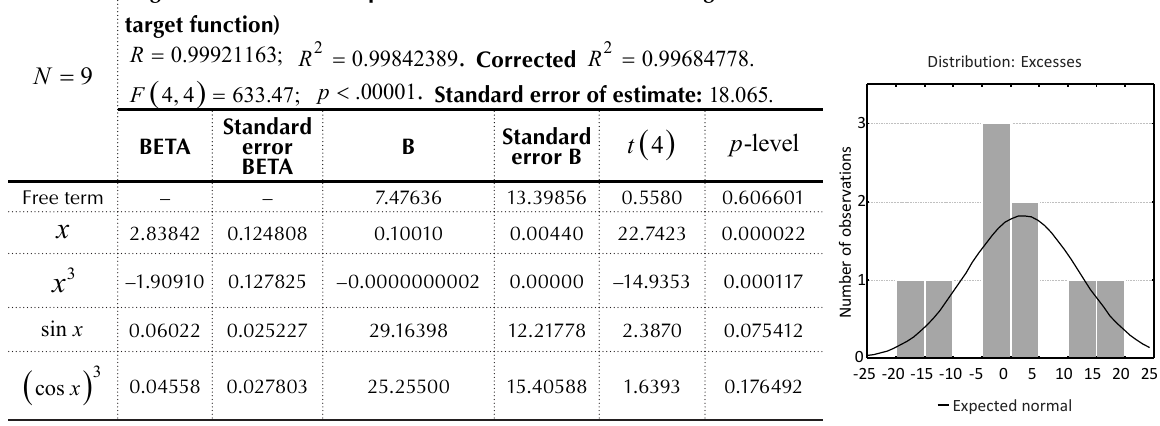
Table 4b. The results of regression for contributions of the members of the Financial Services Compensation Scheme (FSCS) ( ) c from its volume ( ) x